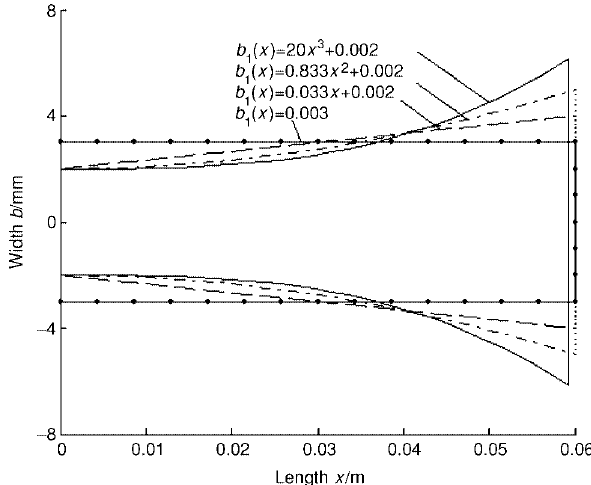
Figure 4 Various configurations of caudal